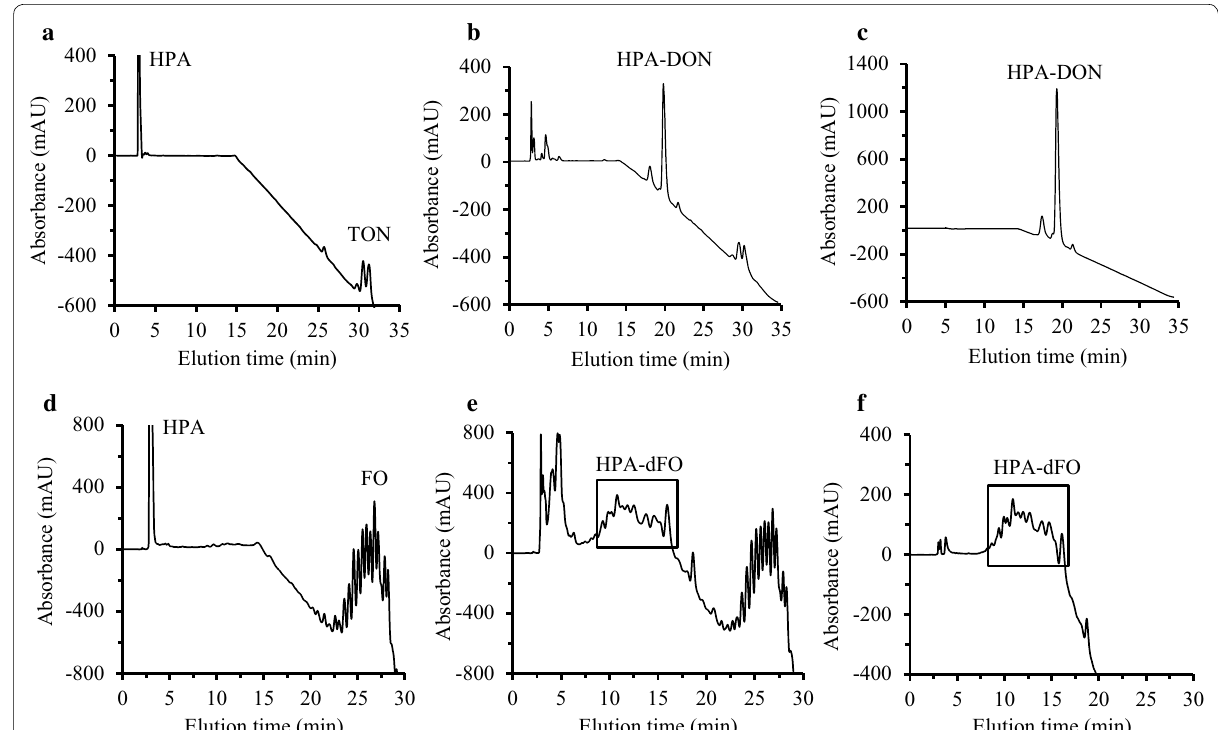
Fig. 2 HPLC chromatography of reaction products. Reaction mixture of HPA and TON was analyzed at a 0 h, and b 24 h. c HPA-DON was purified by Prep-LC. Reaction mixture of HPA and FO was analyzed at d 0 h, and e 24 h. HPA-dFO was purified by